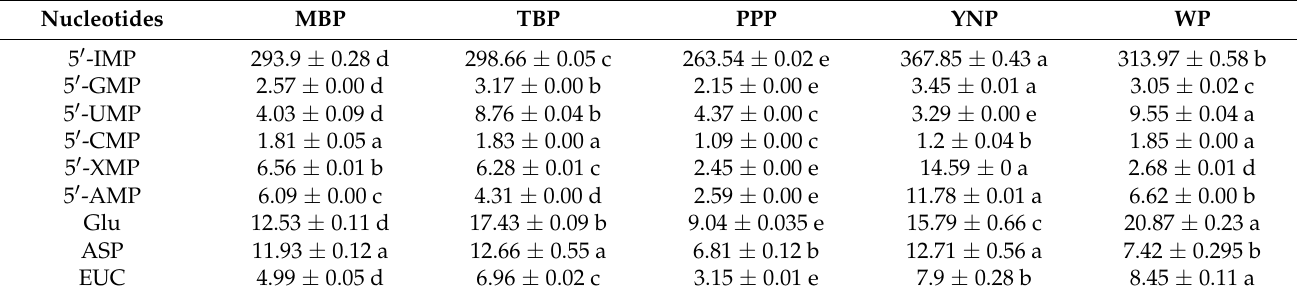
Table 9. Contents of nucleotides in the five types of pork (mg/100